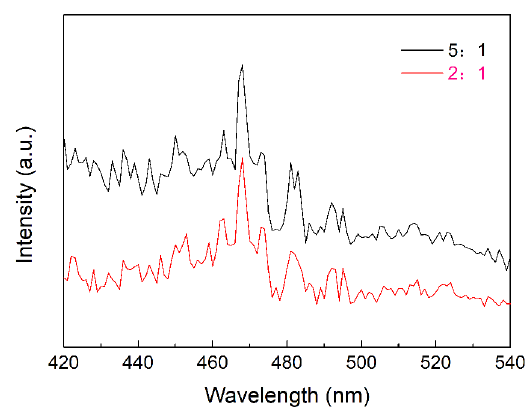
Figure 6. PL spectra of samples synthesized with different salt